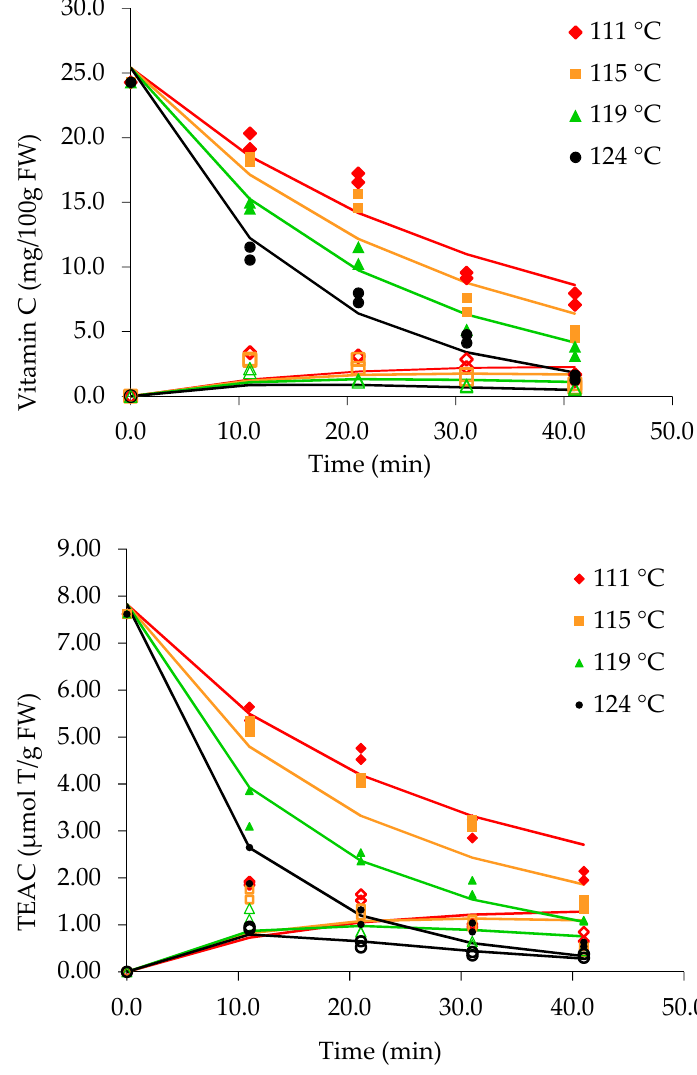
Figure 5. Vitamin C and TEAC concentrations in pineapple pieces (closed symbols) and syrup (open symbols) during canningat different temperatures. Lines are fitted to a model describing degradation and leaching using Equations (1)and(2).